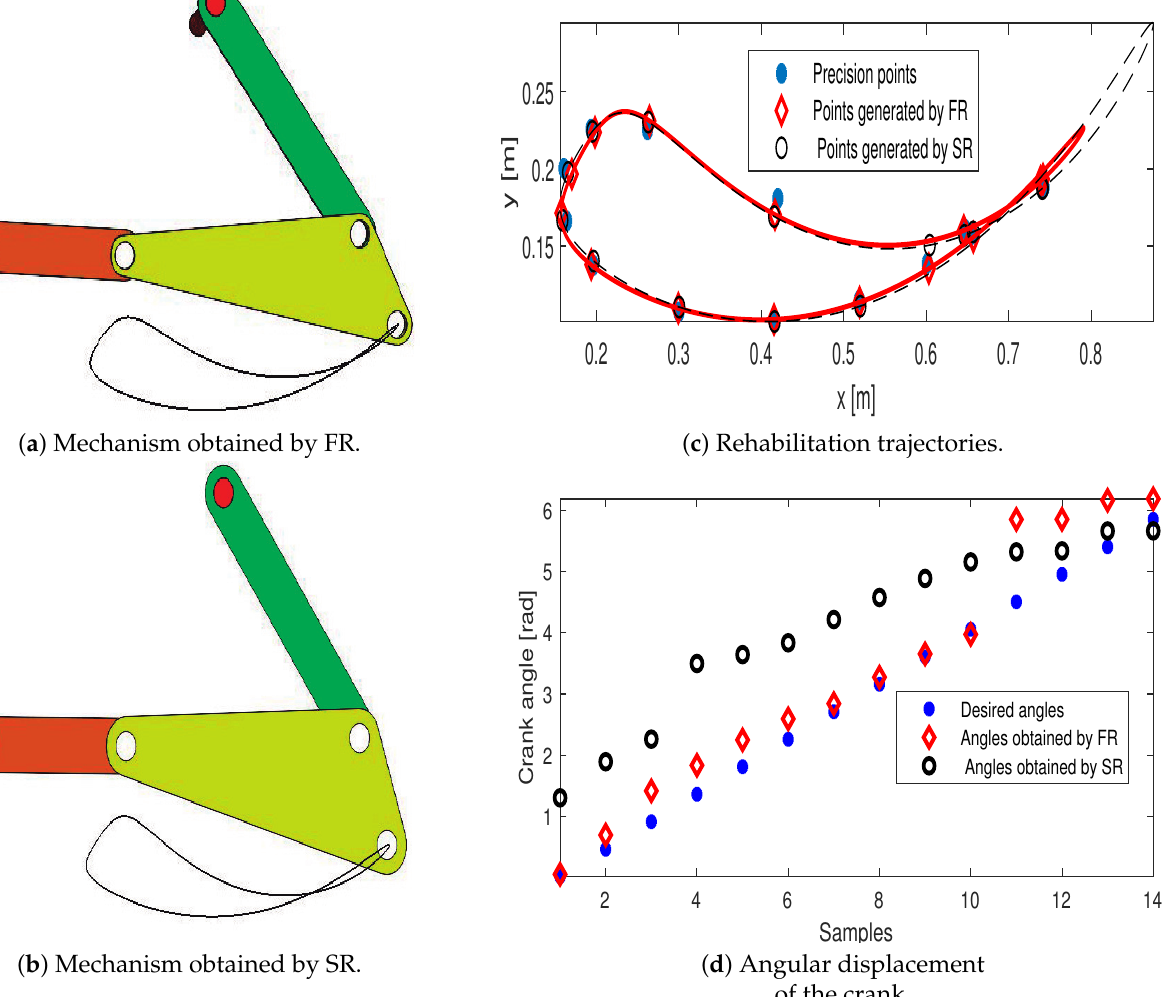
Figure 8. CAD representation and trajectory generated of the mechanisms (design goals) given by the best and the worst constraint-handling technique for solving study case